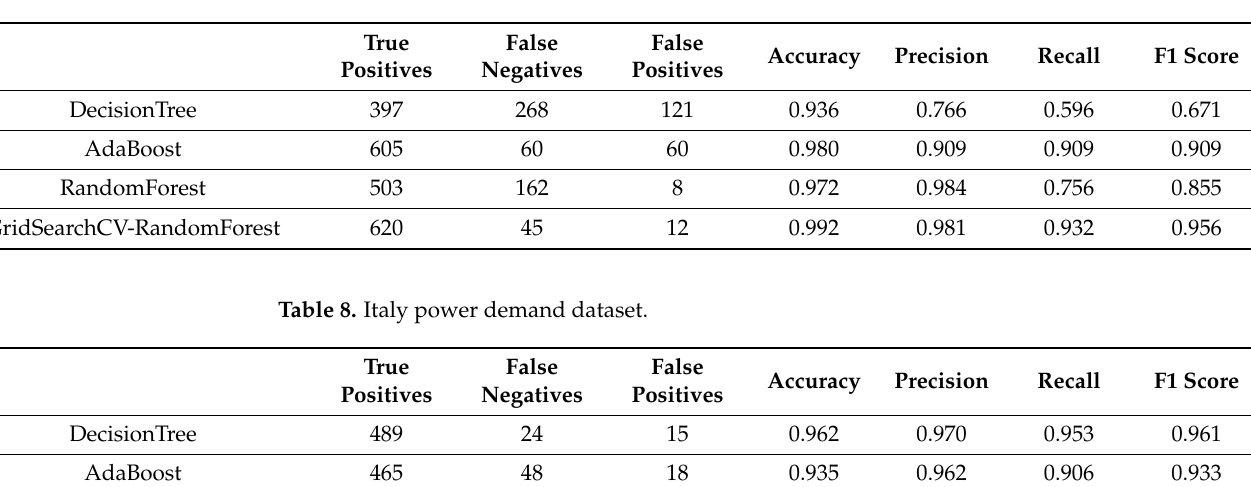
Table 7. Wafer dataset.